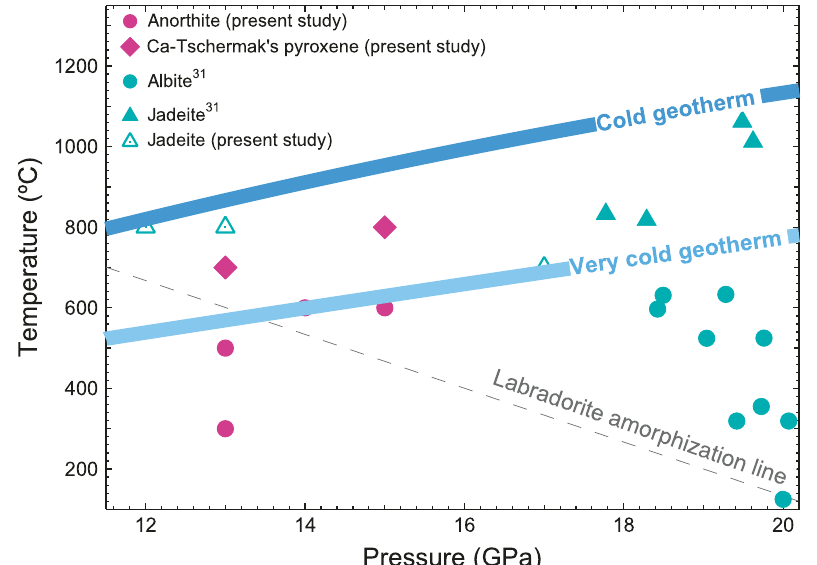
Fig. 4 Phase relations in feldspars of the anorthite-albite series as revealed by multi-anvil experiments in the present study and in the work of Kubo et al. 30 . Cold slab and very cold slab geotherms are from Zhang et al. 41 . The dashed grey line represents the amorphization line of labradorite with a composition of Ab 45.0 An 51.8 Or 3.2 30